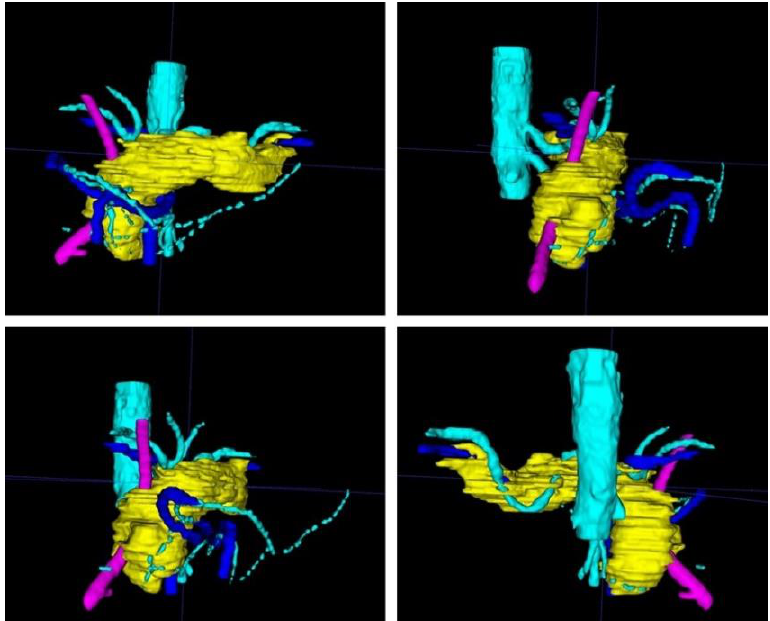
Figure 3. After completion of the final mesh, the pancreas and its surroundings can be viewed from different angles. Note the rather rough surface as the CT scans had a slice thickness of 1 mm. (The pancreas in yellow, the arteries in light blue, the veins in dark blue, and the splint in pink.)